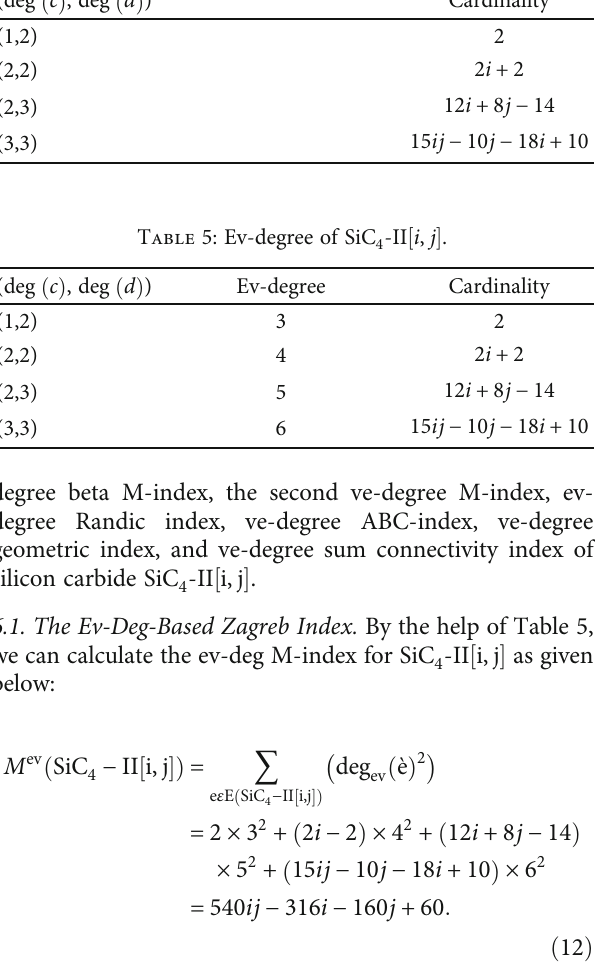
Table 4: Division of edges for SiC